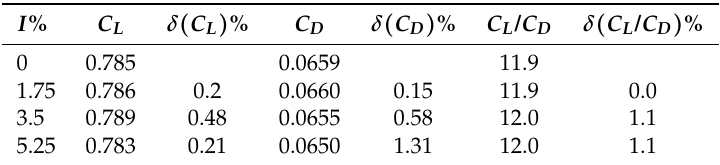
Table 6. Sensitivity study on the inflow turbulence intensity I for Re = 10 4 and AoA = 4 ◦ . δ is the relative difference with the turbulence intensity I = 0%